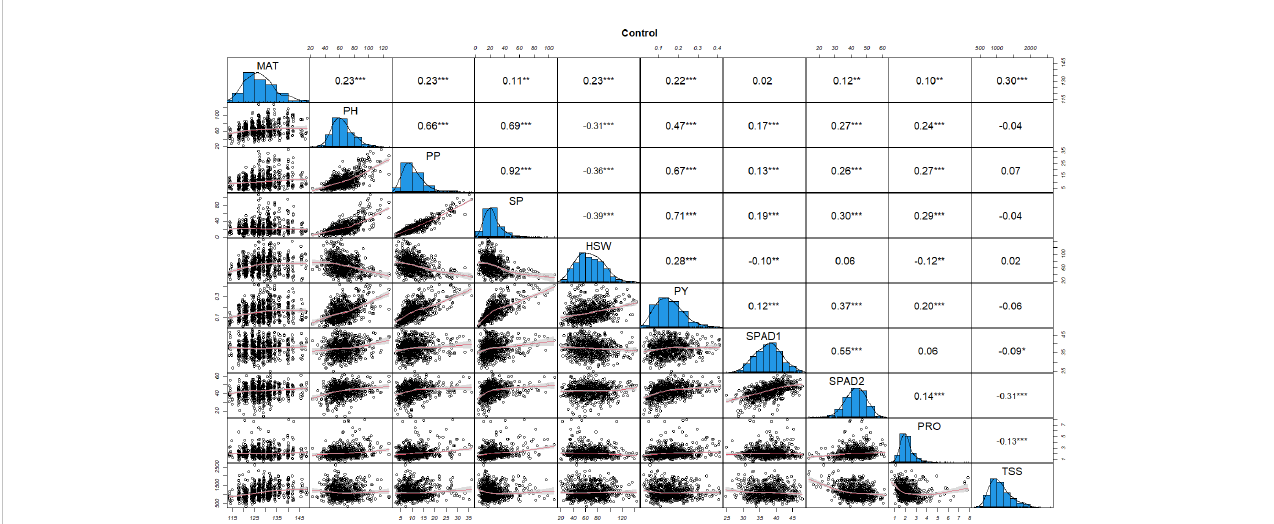
FIGURE 1 Distributions of phenotypic frequency and correlations between 10 morphological, phenological and physiological traits in control conditions. The frequency distribution of each trait is shown on a central diagonal in the form of a histogram. Scatter plots of correlations between every pair of traits are shown in the areas below the diagonal, and numerical Pearson ’ s correlation coef fi cients (r), between every pair of traits are shown in the areas above the diagonal. The red line in the scatter plots represents the slope of the correlations. The x- and y- axes are the values of the measurements (PH in cm,